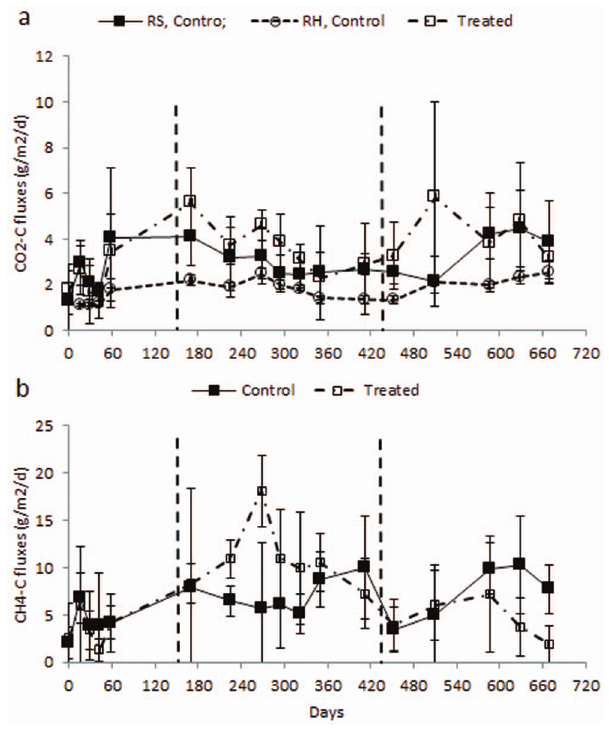
Figure 2. Mean ( ± 95% CI) Carbon emissions. a) CO 2 fluxes of total sediment respiration (R S ) (solid line with filled squares), heterotrophic respiration (R H ) (dashed line with open circles) in control plots and CO 2 fluxes from treated plots (broken line with open squares) and b) CH 4 emissions in R. mucronata forest at Gazi bay Kenya. Vertical broken lines indicate periods when trees were girdled and cut in the treatment plots. Sampling for baseline, girdled and cut periods were done from June 2009 to August 2009 (84 days), December 2009 to May 2010 (189 days) and May 2010 to April 2011 (343 days), respectively. The controls and the treatment consisted of five replicates each.